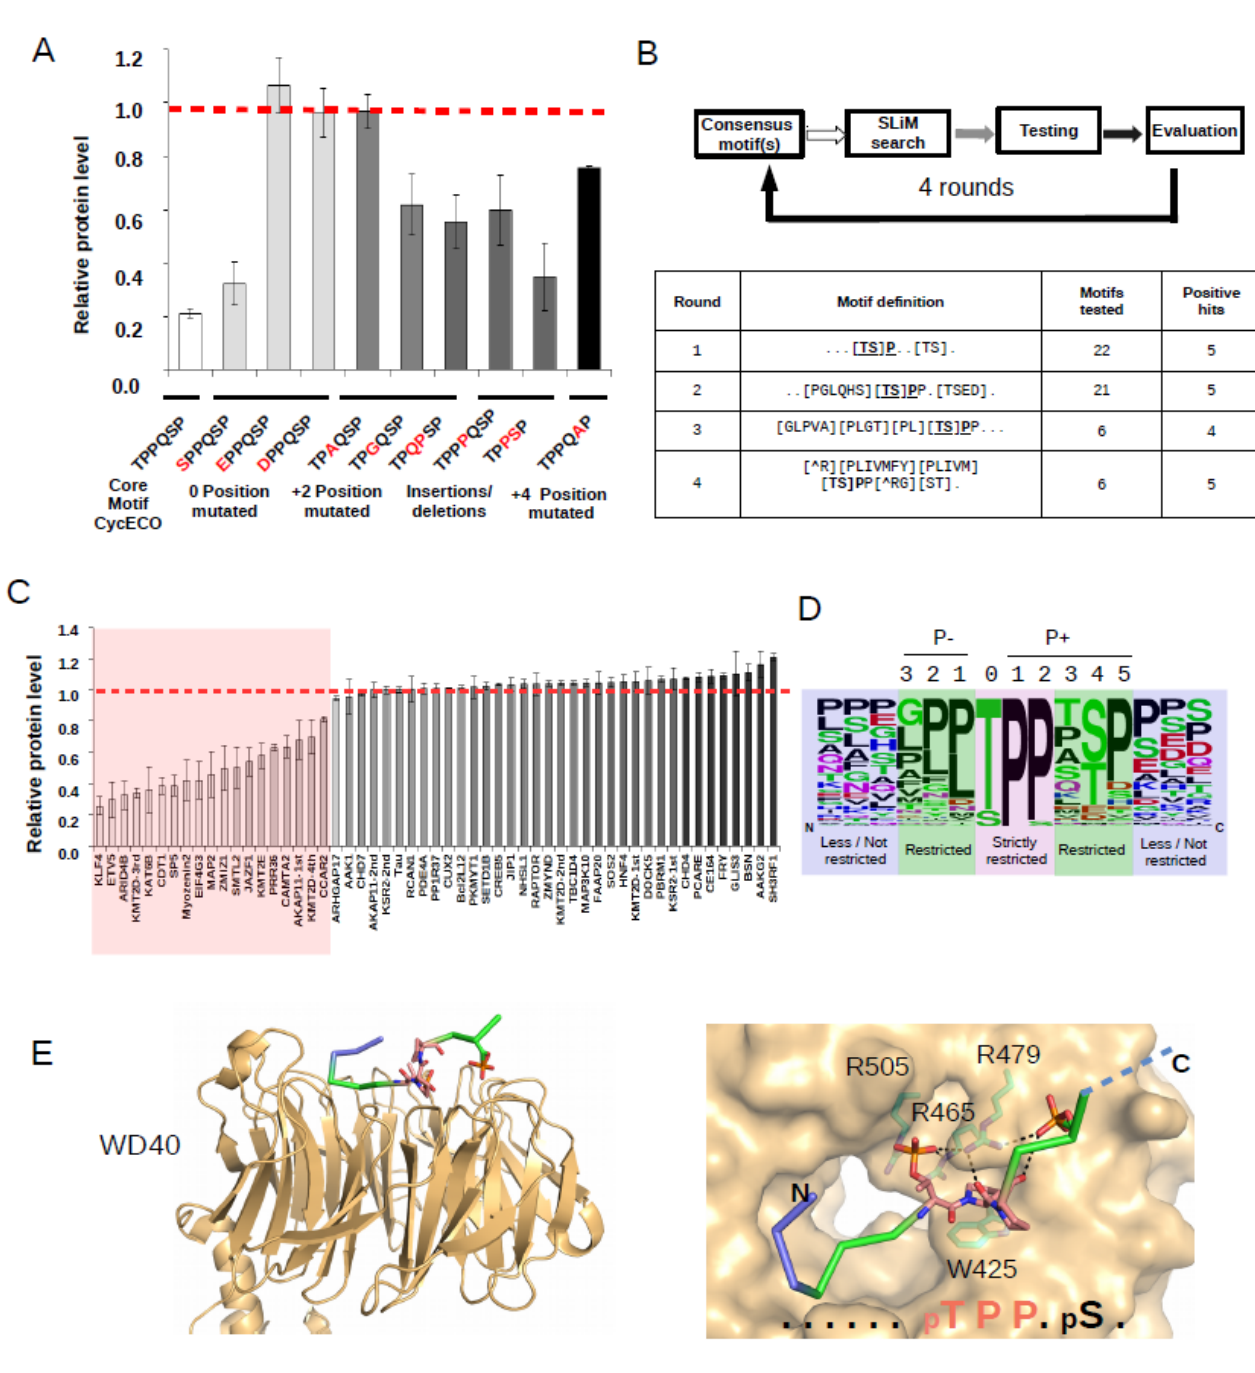
Figure 2. Refinement of the FBXW7 phosphodegron consensus. ( A ) Mutational analysis with the CycECO degron. The relative protein level of the CycECO probe was monitored in HEK293T cells (where the EGFP/DsRed ratio measured in FBXW7 plasmid transfected cells was normalized to the EGFP/DsRed ratio of control cells, where the latter were not transfected by the FBXW7 expression plasmid). Amino acid replacements/changes compared to the TPPQSP core motif are shown in red. ( B ) The scheme of the hierarchic strategy that coupled sequence pattern-based motif identification from the disordered part of the human proteome with experimental testing of chosen motifs in the ratiometric EGFP/DsRed degradation assay. The underlined residues denote the P0 position in the degron motif. ( C ) Experimental testing of putative motifs identified 19 novel phosphodegrons (ordered from strong to weak). ( D ) Sequence logo created based on all formerly known positive and the newly found 19 human positive phosphodegrons (see Supplementary Table S2). ( E ) Position